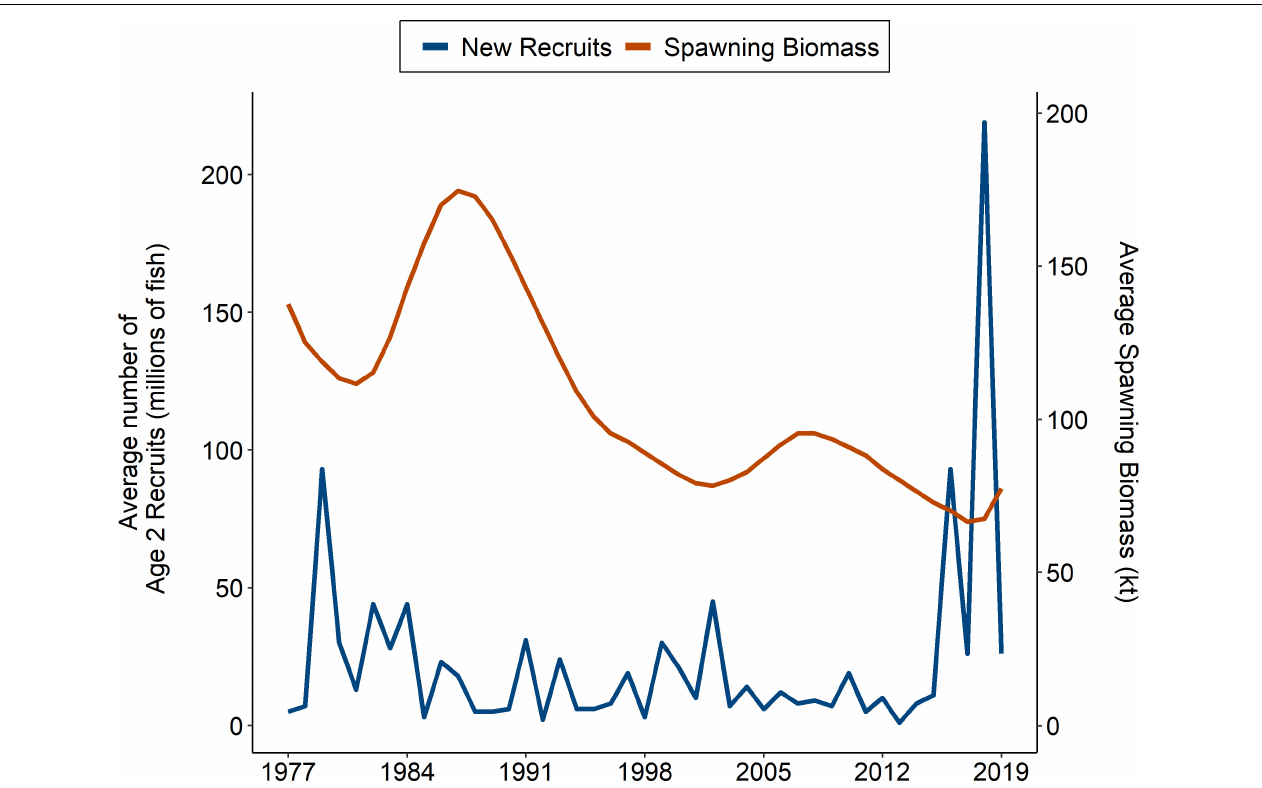
FIGURE 1 | Age-2 sablefish recruits and spawning biomass of sablefish in Alaska from 1977 to 2019. The blue line and primary y -axis indicate the average number of age 2-recruits; the orange line and secondary y -axis indicate the average spawning